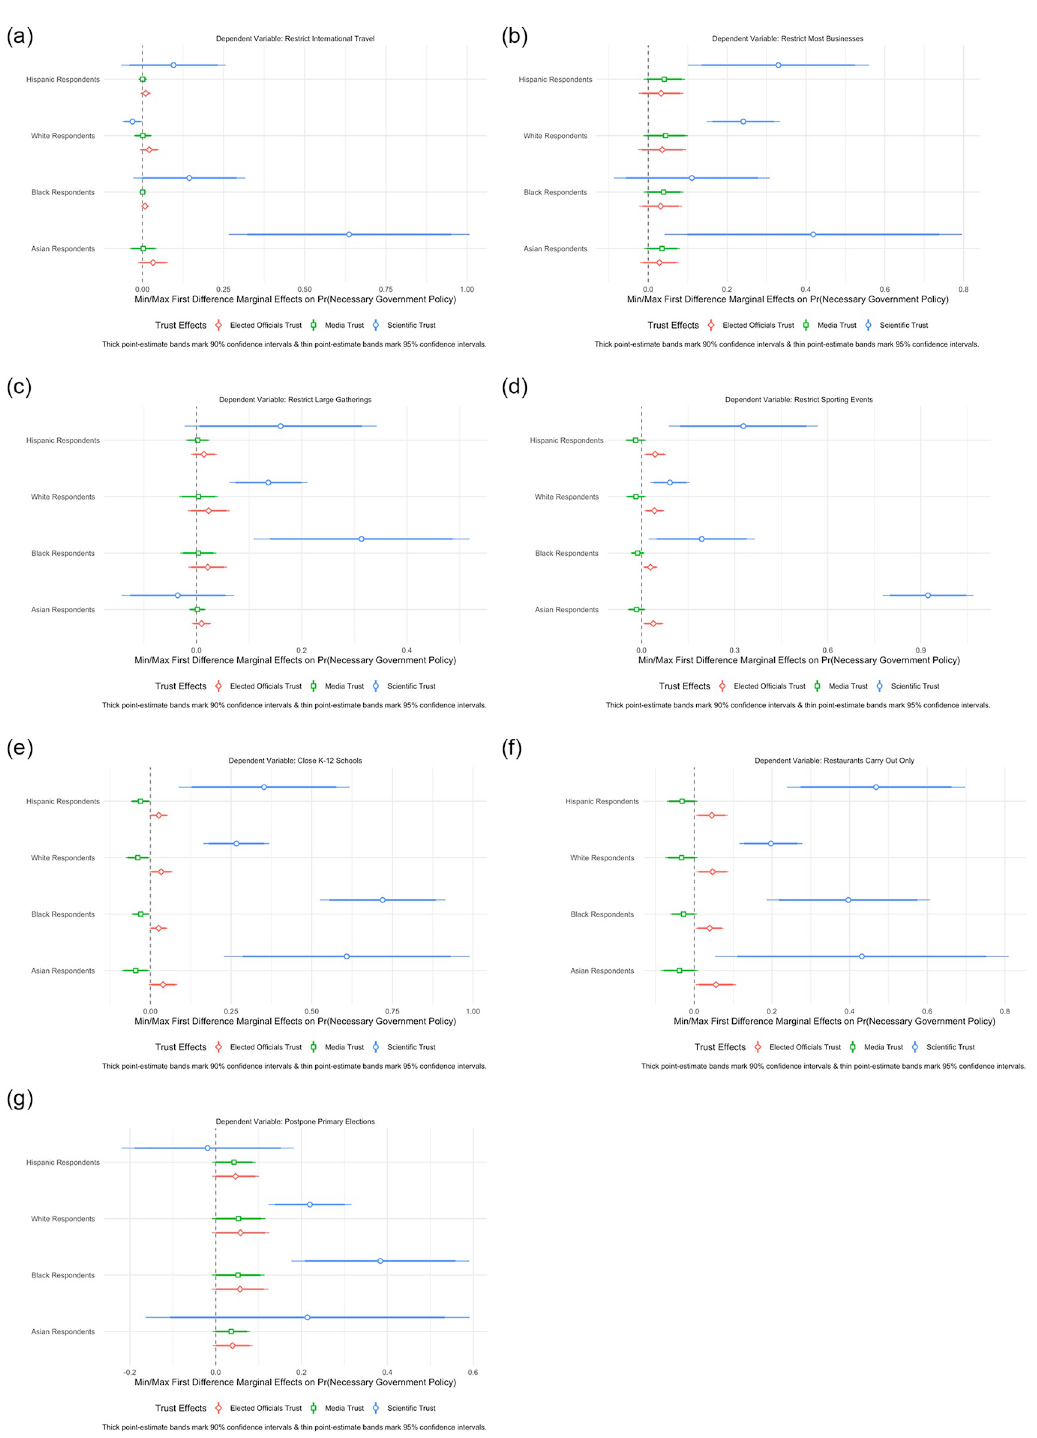
Fig 5. Measuring latent scientific trust in the mass public. A: Restrict international travel. B: Close most businesses. C: Restrict large gatherings. D: Restrict major large & sporting events. E: Restrict K–12 schooling. F: Restrict restaurant dining. G: Postpone primary